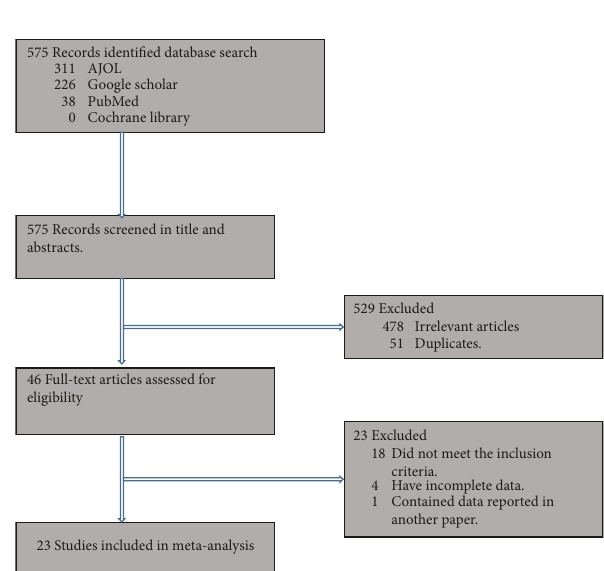
Figure 1: PRISMA flow chart of the article selection